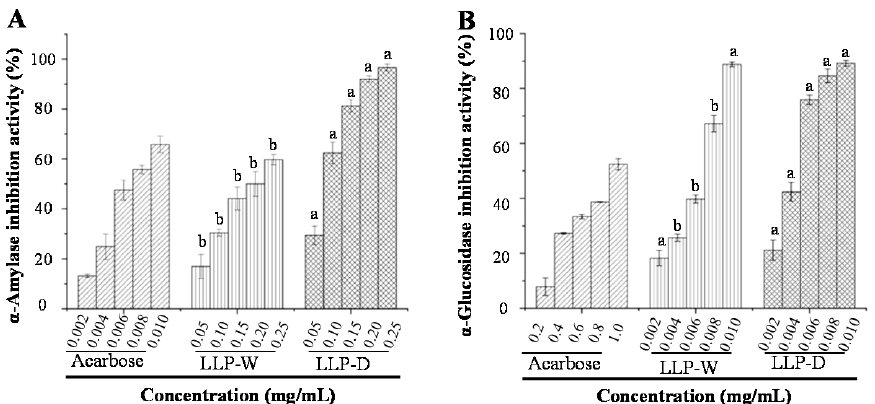
Figure 7. Inhibitory effects against α -amylase ( A ) and α -glucosidase ( B ) of LLP-D and LLP-W. Each experiment was operated in triplicate, and the error bars are standard deviations; Significant ( p < 0.05) differences are shown by data bearing different letters (a and b).